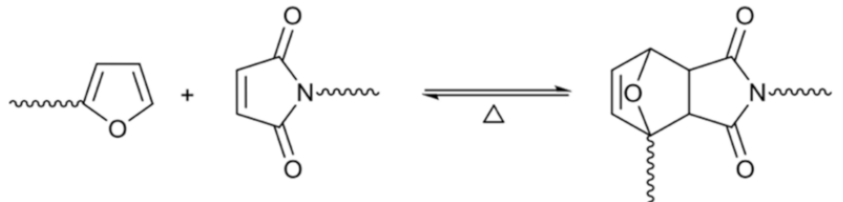
Figure 7. The DA equilibrium governing the polycondensations of furan and maleimide